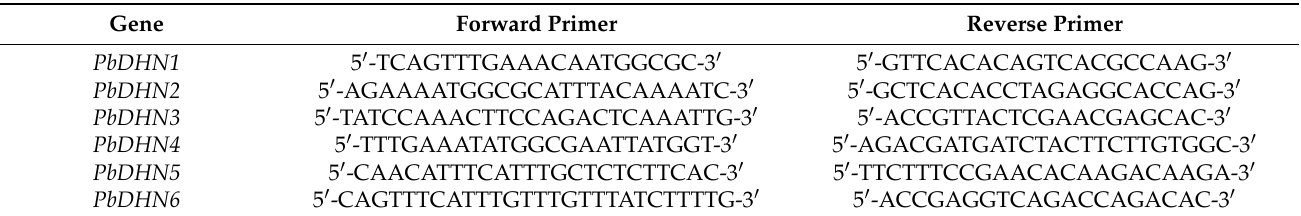
Table 1. Sequence of primers for the PbDNH s